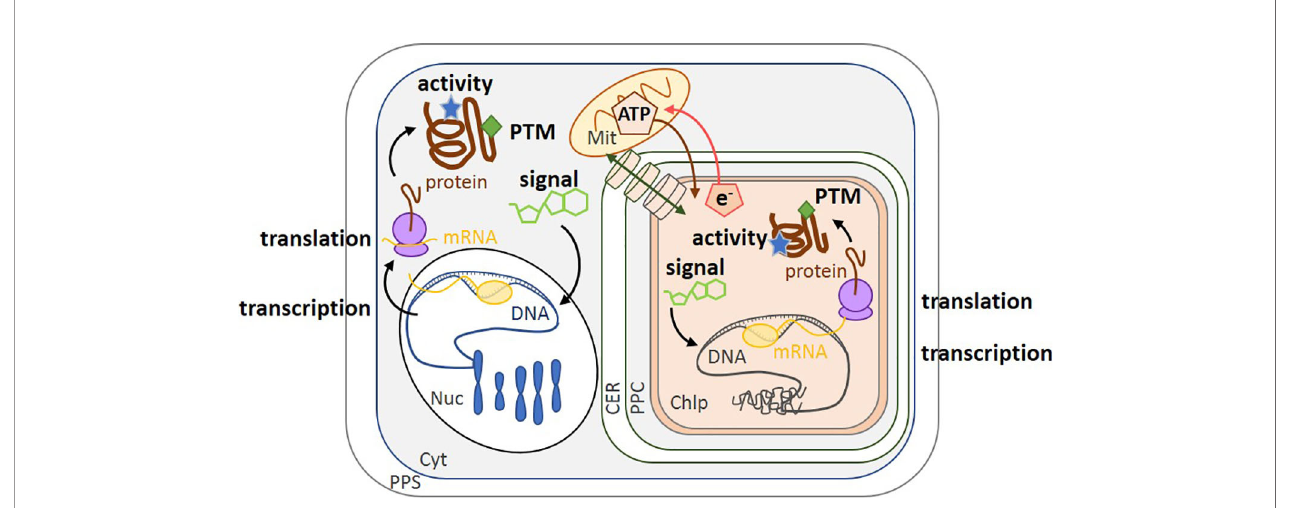
FIGURE 1 | Schematic of the different levels of regulation in diatoms. Transcription of the genome by mRNA polymerase (yellow circle) converts nuclear DNA (blue) and chloroplast DNA (gray) into mRNA (yellow). Translation by the ribosome (purple) converts mRNA into protein (brown). Regulation can also be modulated by enzyme activity (blue stars), post-translational modi fi cation (green diamonds) and small molecules such as co-factors or metabolites (green carbon skeletons). The transport of molecules between the cytoplasm and the chloroplast is represented by a green double-headed arrow across cylinders. ATP synthesized in the mitochondrion can be transported into the chloroplast (brown arrow), while the reducing power (e.g., NADPH, represented by e - ) of the chloroplast is transported to the mitochondrion (red arrow) (Bailleul et al., 2015). PPS, Periplasmic Space; CER, Chloroplast Endoplasmic Reticulum; PPC, Periplastidial Compartment; Mit, Mitochondrion; Chlp, Chloroplast; Cyt, Cytoplasm; PTM, Post-Translational Modi fi cation; Nuc,